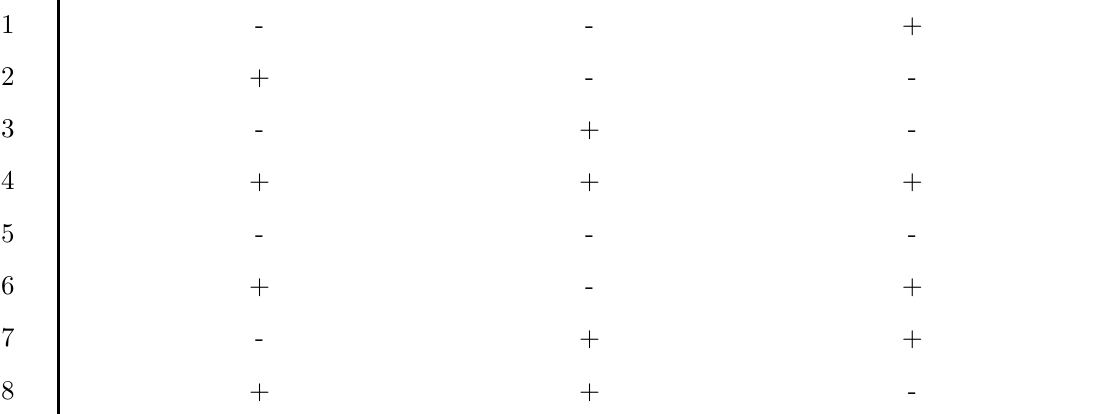
Table 4 Boundary levels of variable factors and a matrix of the mathematic planning of an